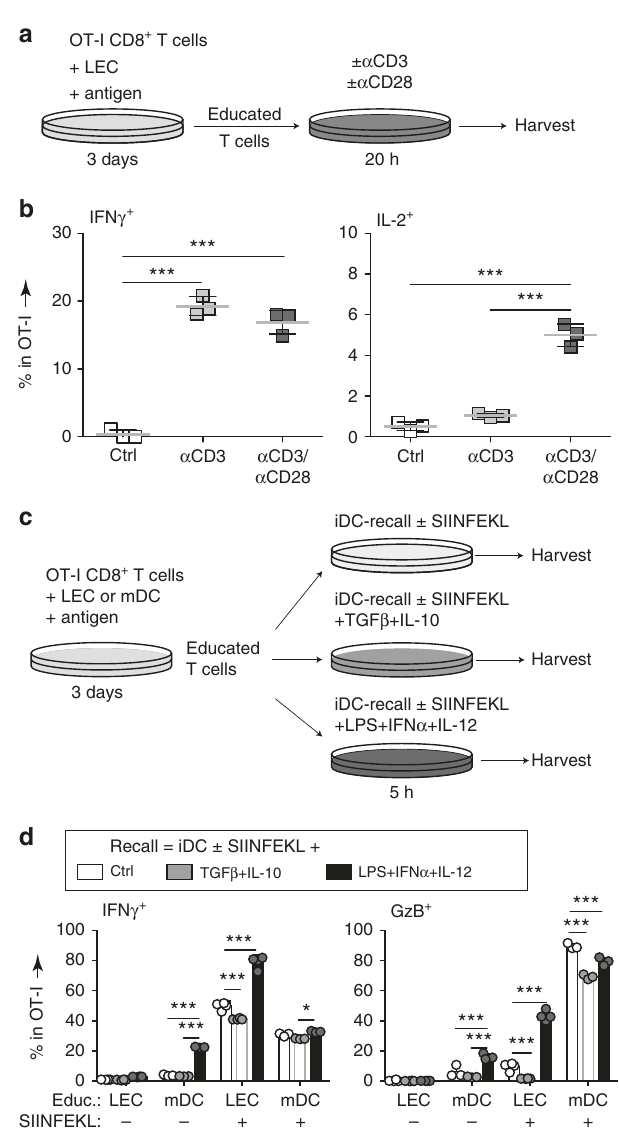
Fig. 9 Stringent requirements for reactivation of LEC-educated CD8 + T cells into functional effector cells. a Experimental schedule for b . LEC- educated OT-I CD8 + T cells were re-stimulated with plate-bound CD3 ± CD28 agonist antibodies, and b intracellular IFN γ and IL-2 expressions were quanti fi ed by fl ow cytometry as a frequency of live OT-I cells. c Experimental schedule for d . LEC or mDC-educated OT-I CD8 + T cells were re-stimulated with immature DCs (iDCs; pre-pulsed with or without SIINFEKL before co-culture) in the presence of immunogenic (LPS, IFN α , and IL-12) or immunoregulatory (IL-10 and TGF β ) cytokines, or iDCs alone (Ctrl) for 5 h. d Frequency of IFN γ + and GzB + (intracellular) cells among live OT-I cells quanti fi ed by fl ow cytometry. Data points and error bars depict mean ± SD for n = 3 replicates from one representative of two independent experiments. * p < 0.05, ** p < 0.01,*** p < 0.001 via one-way b or two-way d ANOVA with Bonferroni ’ s